Question: Condense the content of this figure into a single sentence.
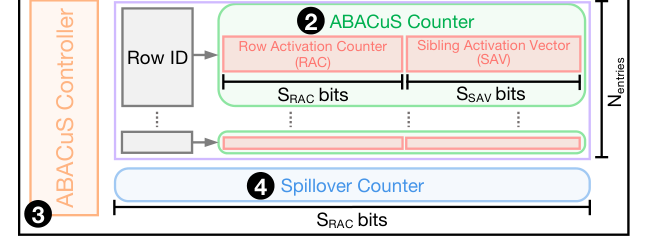
Answer: Key components of ABACuS The row activation counter (RAC) in an ABACuS counter (❷) stores the maximum activation count across all sibling rows’ activation counts. The sibling activation vector (SAV) stores the sibling activation bits used by ABACuS to increment the RAC only when necessary (see §4). The ABACuS controller updates RAC and SAV to ensure the maximum activation count among all sibling rows is tracked in the RAC. 4.2. Operation of ABACuS We describe ABACuS’s operation in five key steps: i) initial- ization, ii) ABACuS counter table search, iii) ABACuS counter update, iv) ABACuS counter replacement, and v) periodic reset. (1) Initialization and Reset. Initially (at system power on) and after periodic ABACuS counter table reset (Step 5), no DRAM row is activated for the last tREF W . Thus, row activa- tion counters (RACs) and sibling activation vectors (SAVs) in all ABACuS counters and the spillover counter all store 0. (2) ABACuS Counter Table Search. The memory cont